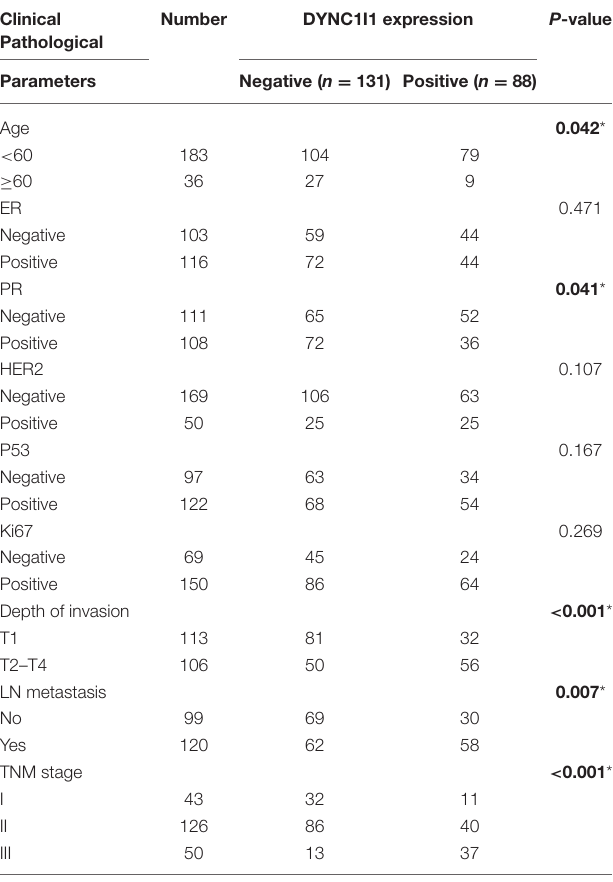
TABLE 4 | Correlation between DYNC1I1 expression and clinical characteristics in breast cancer patients ( n =